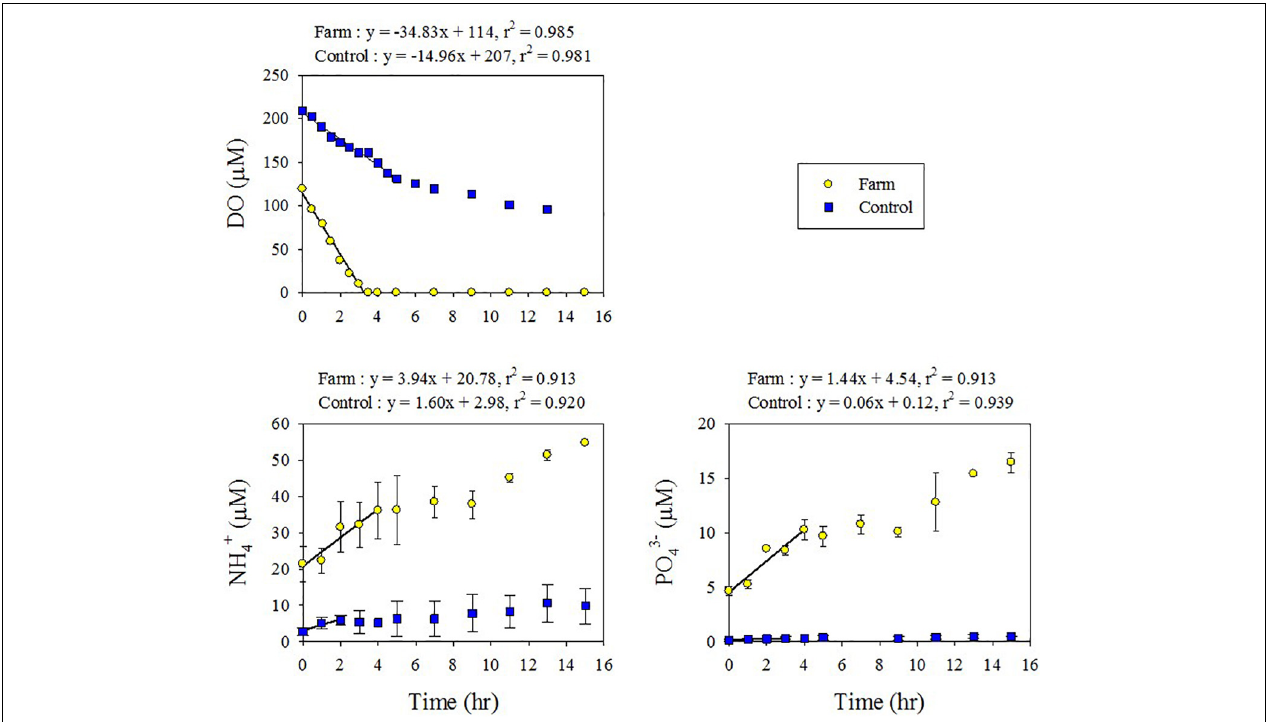
FIGURE 4 | Changes in dissolved oxygen (DO), NH 4 + , and PO 43 - concentrations with time in the benthic chamber of the fish farm and control sediment. Note that the regression lines were derived from first 4 h of incubation before the depletion of oxygen concentration in the fish farm sediment sample. TABLE 5 | Nutrient demand for primary production (PP), benthic nutrient flux (BNF), and contribution of BNF to PP.